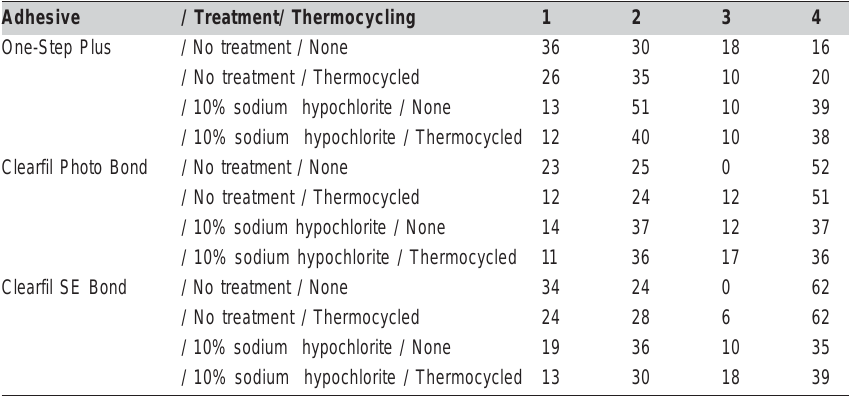
Table 4. Failure modes distribution (%) according to the experimental